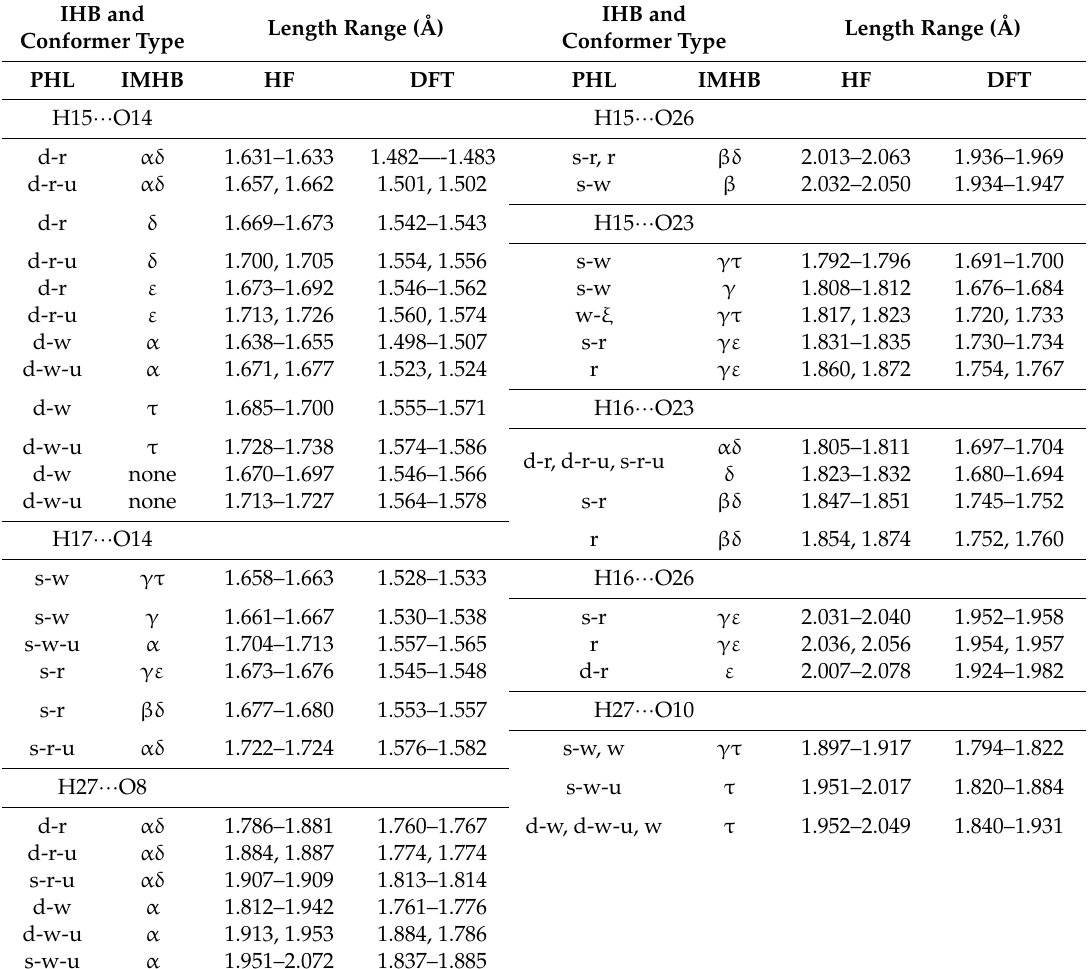
Table 3. Ranges of the length of the IHBs in the calculated conformers of arzanol. HF/6-31G(d,p) and DFT/B3LYP/6-31+G(d,p) results in vacuo, respectively denoted as HF and DFT in the column headings. The types of conformers are characterised by the features that prove relevant in relation to the ranges of the given IHB, i.e., the first IHB and the orientations of the other phenol OHs (under the PHL heading) and the types and combinations of IMHB (under the IMHB heading). When only two values are available for a given type, they are both reported, separated by a comma, and in the same sequence in the HF and DFT